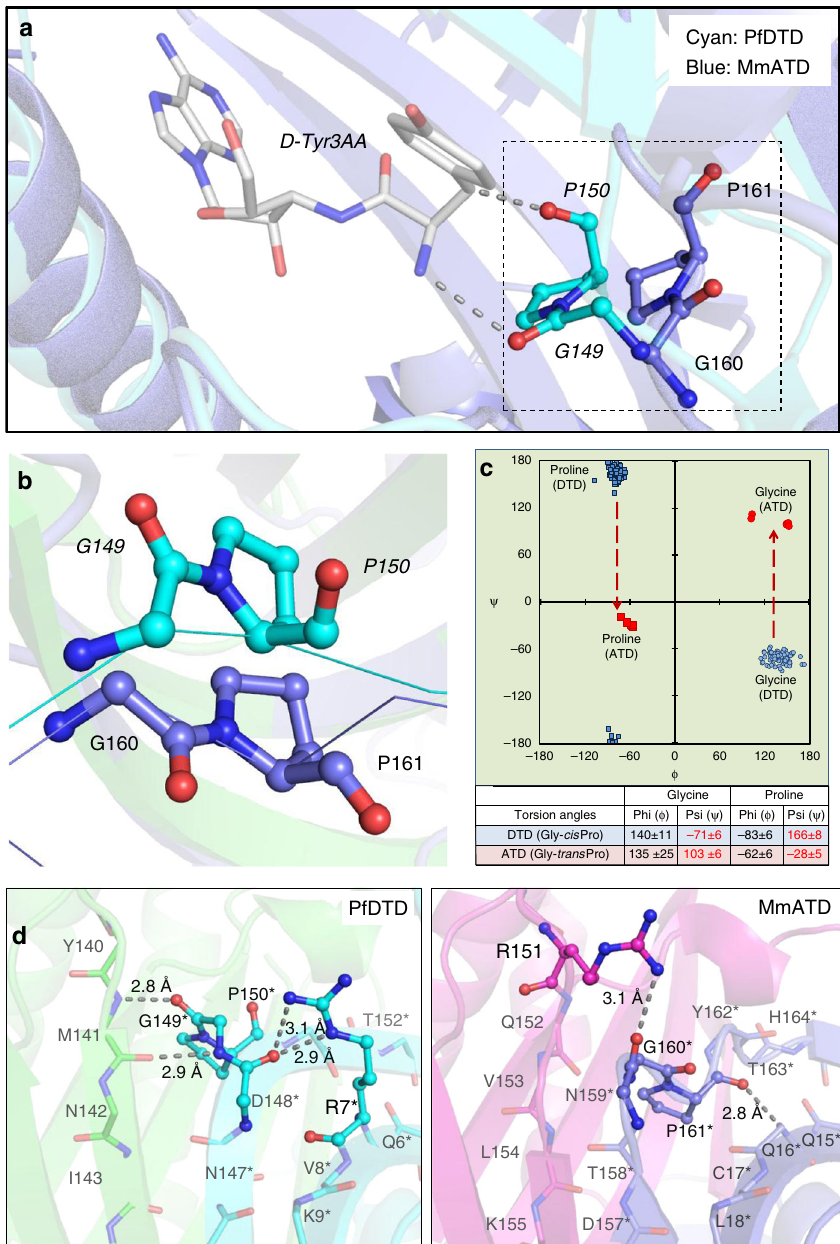
Fig. 3 ATD has a Gly- trans Pro motif in the active site, unlike a Gly- cis Pro motif in DTD. a Comparison between Gly- trans Pro motif in MmATD and Gly- cis Pro motif in PfDTD (PDB id: 4NBI) after structural superposition of the two proteins. b The comparison shown in a depicted from a different angle, highlighting the opposite orientation of Gly-Pro carbonyl oxygens of the two proteins. c Ramachandran plot of glycine and proline residues of the Gly-Pro motif of all the available crystal structures of DTD (blue) and ATD (red), highlighting the change of ~180° in the ψ torsion angle. d Interaction of the side chain of Arg7 with the Gly- cis Pro motif of the same monomer in PfDTD (PDB id: 4NBI), and of the side chain of Arg151 with the Gly- trans Pro motif of the dimeric counterpart in MmATD. Residues from the dimeric counterpart are indicated by